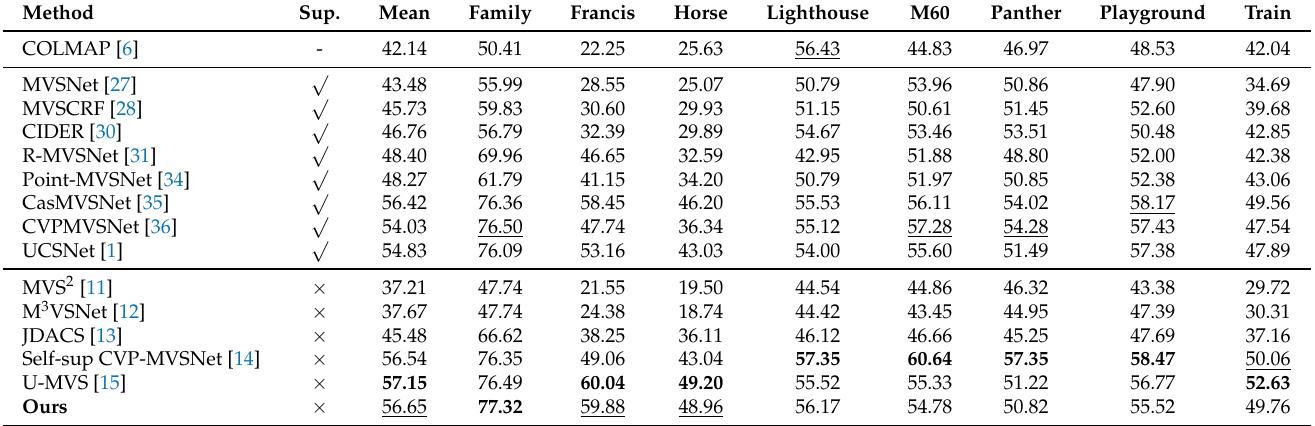
Table 3. The performance of our approach on the Tanks and Temples benchmark (intermediate set) with F score (%) (higher is better). The best results are in bold, while the second ones are underlined. Method